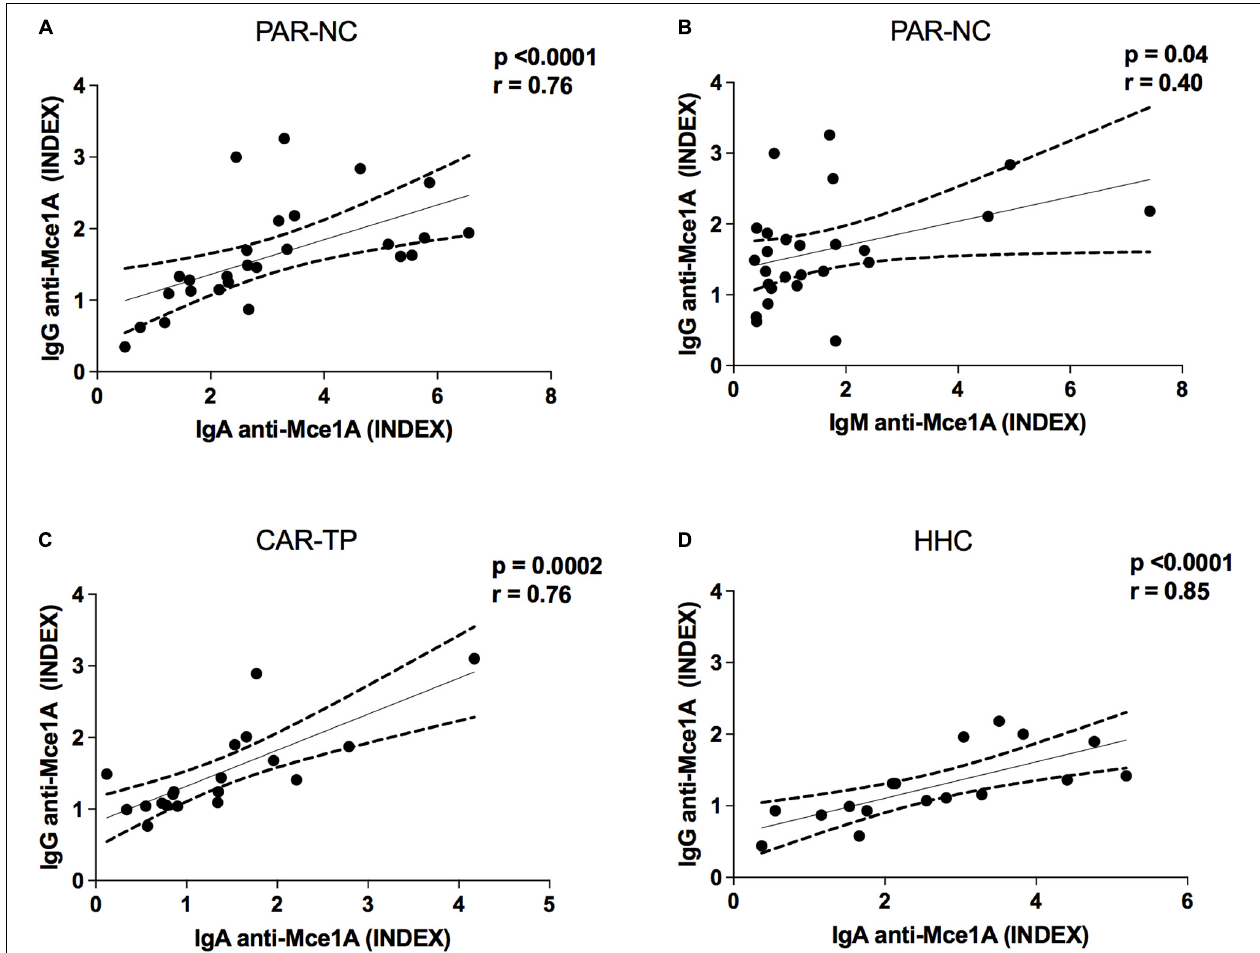
FIGURE 4 | Immunoglobulins correlation profile in HD. Spearman’s correlation coefficient was used to compare immunoglobulin indices. PAR-NC new cases of HD in Parnaíba (A,B) ; CAR-TP patients treated in Colony Carpina (C) ; HHC household contacts of HD patients in Parnaíba (D)